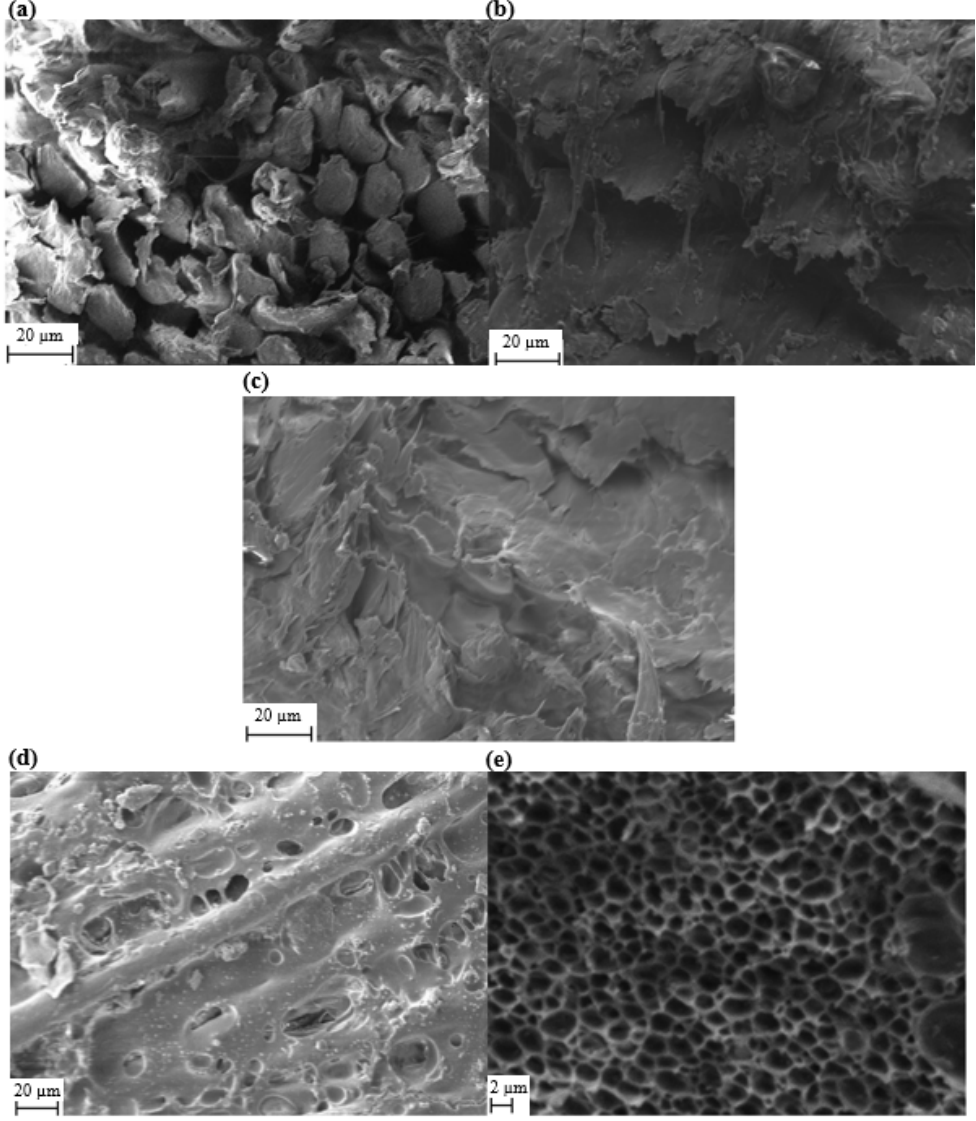
Figure 1. ( a ) Cross-section view SEM photo of sample PC 1:9, ( b ) sample PC 3:7, ( c ) sample PC 5:5, ( d ) plain view SEM photo of sample PC 3:7 and ( e ) high magnification plain view SEM photo of sample PC 3:7.